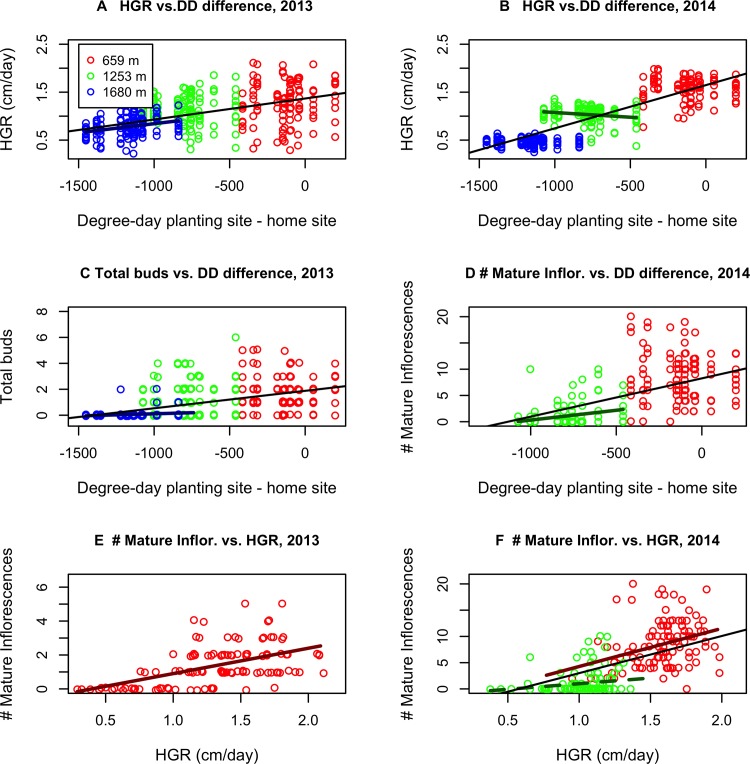
Performance of plants when planted at 3 common gardens along an elevation transect.(A) Height growth rate (HGR) versus difference in average degree-days (DD) between planting site and home site in 2013. (B) HGR vs. difference in DD between planting site and home site in 2014. (C) Total inflorescence buds vs. DD difference in 2013. (D) Number of mature inflorescences vs. DD difference in 2014. E & F—Number of mature flowers vs. HGR in 2013 & 2014. Inflorescences matured (flowers senesced) before end of growing season only at lowest site in 2013 and low and middle sites in 2014. Thick colored lines indicate within-site relationships. Thin black lines indicate across-site relationships. Solid lines indicate statistically significant relationships. Dashed lines indicate marginally significant relationship (p<0.1).